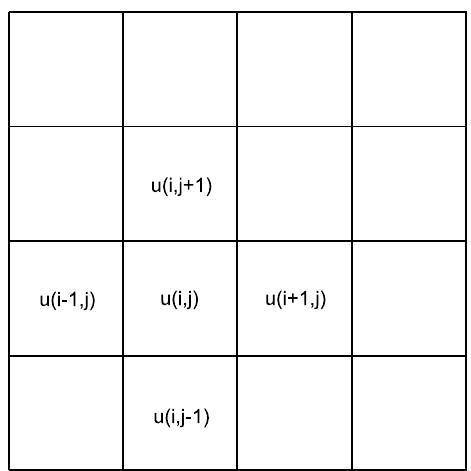
Figure 4. Schematic of L matrix for a center grid